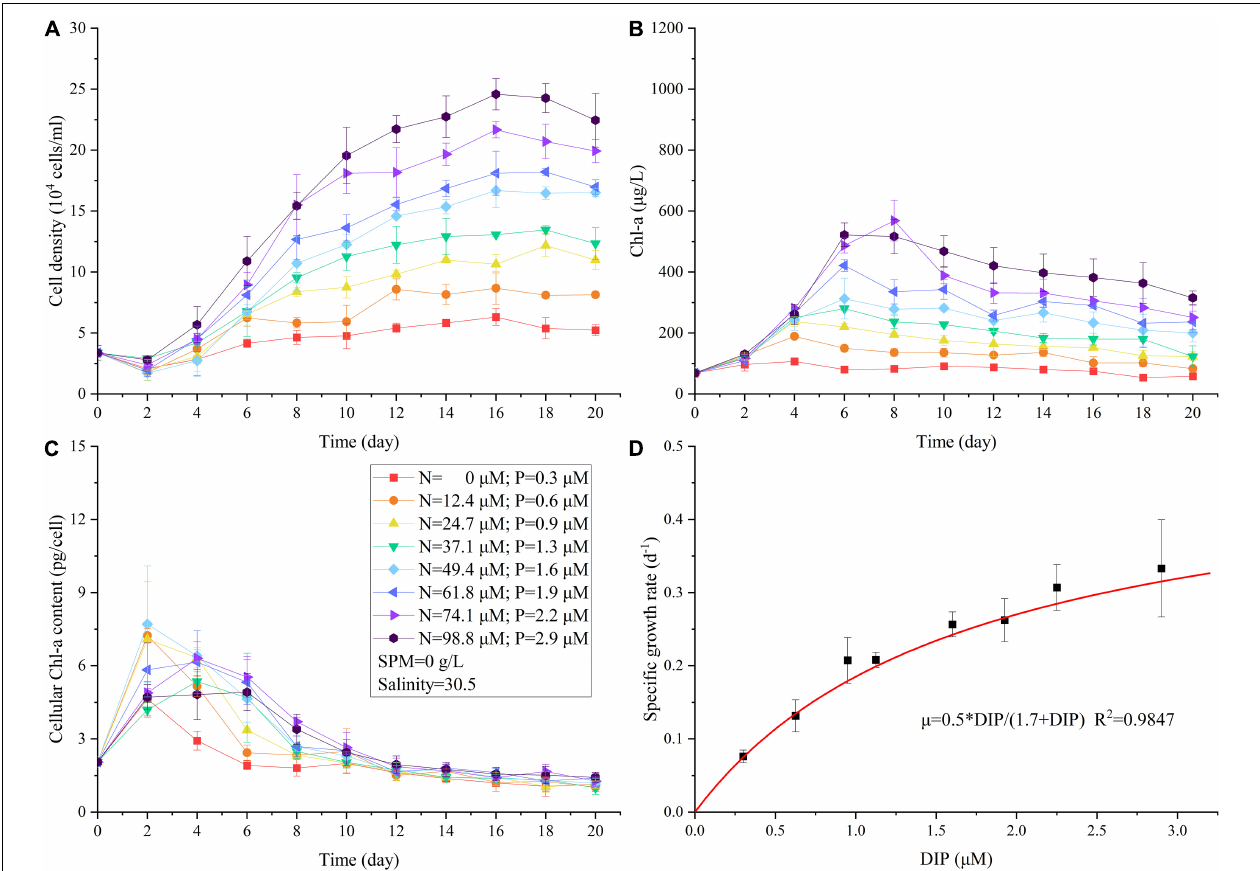
FIGURE 2 | The changes in cell density (A) , Chl- a concentration (B) , cellular Chl- a content (C) under different nutrient concentrations in the single-factor nutrient experiment. The relationship between specific growth rate of A. carterae and concentration of DIP